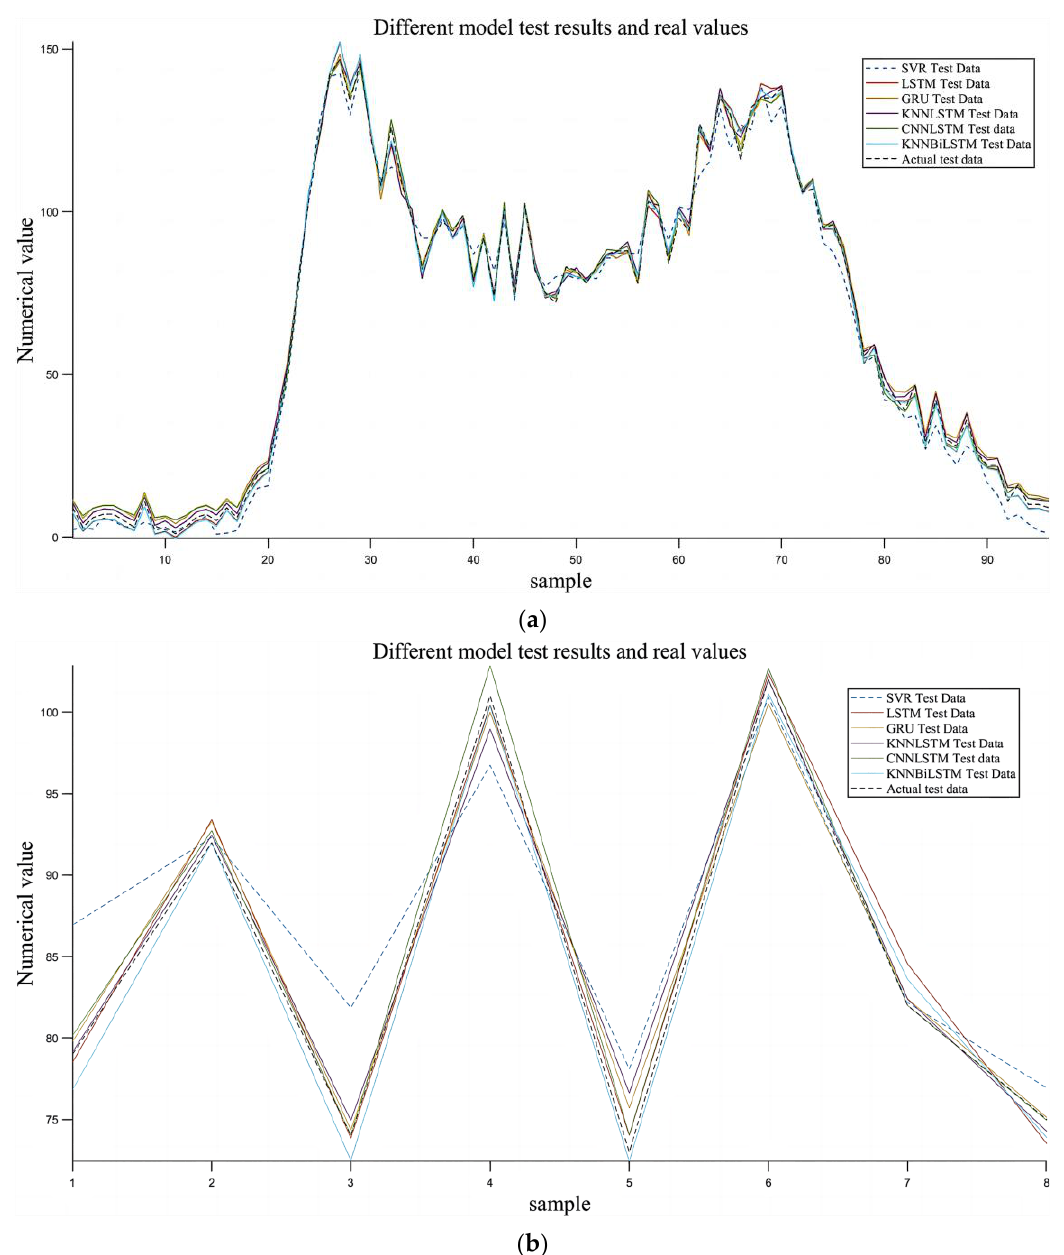
Figure 11. Comparison of errors in prediction results of the different models. ( a ) Used a day’s data sample for prediction. ( b ) Used a total of 8 samples of 40 – 47 from Figure ( a ) for amplification. Table 3. Error table of prediction results of the different models.